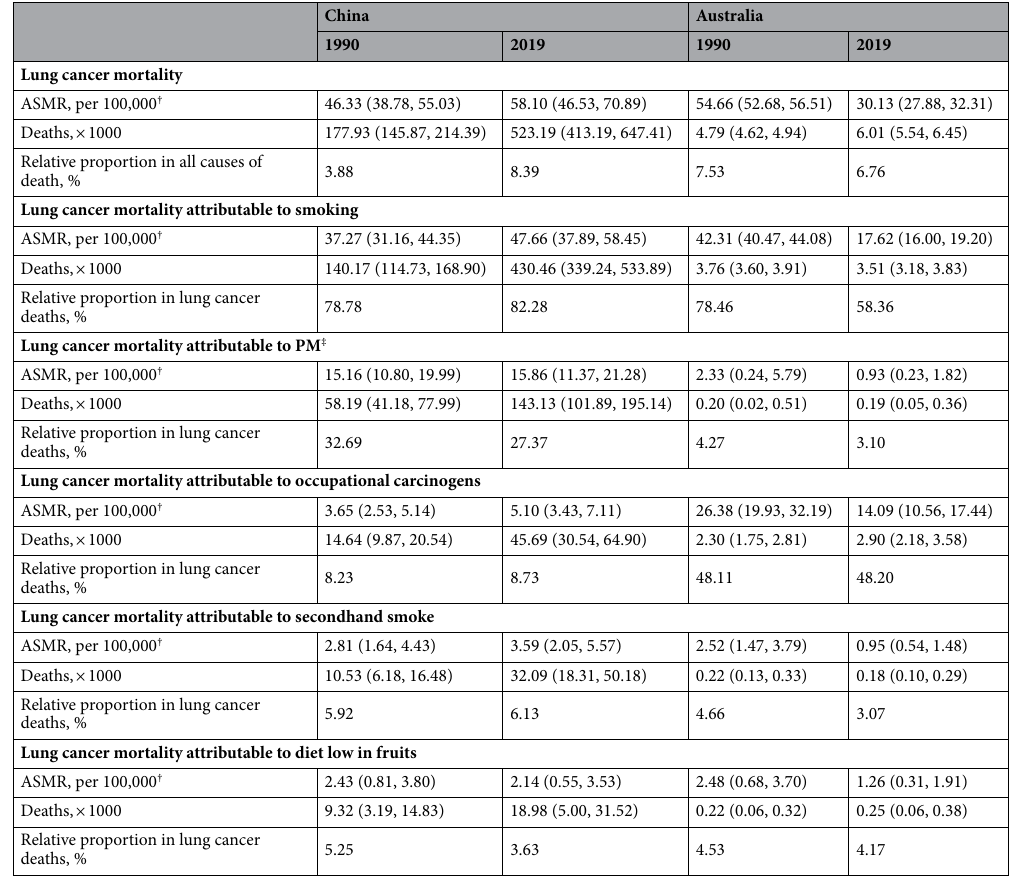
Table 1. Lung cancer mortality among men in China and Australia between 1990 and 2019. †ASMR: age- standardized mortality rate; ‡PM: particulate matter including ambient particulate matter pollution and household air pollution from solid